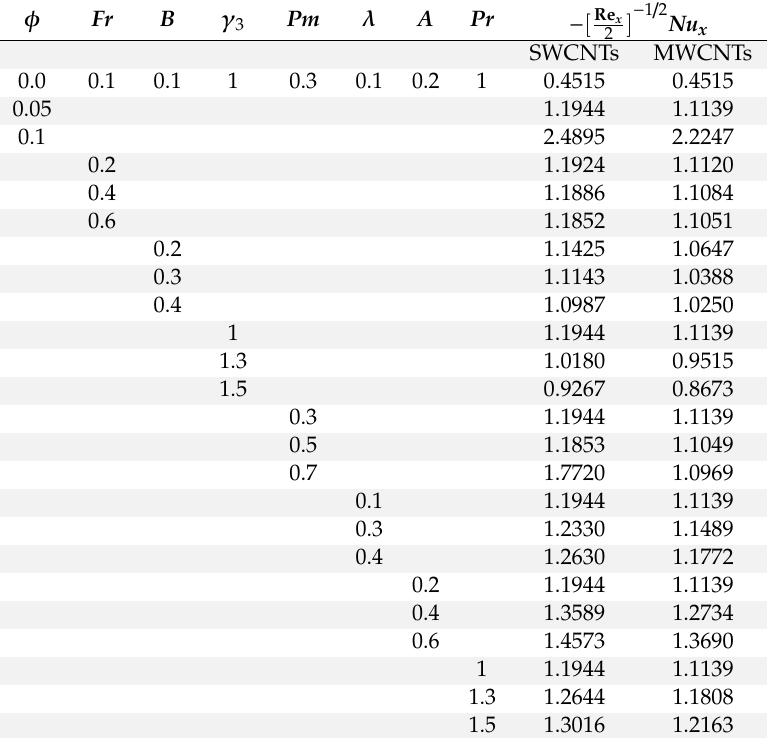
Table 3. Local Nusselt number for engine oil base fluid for various